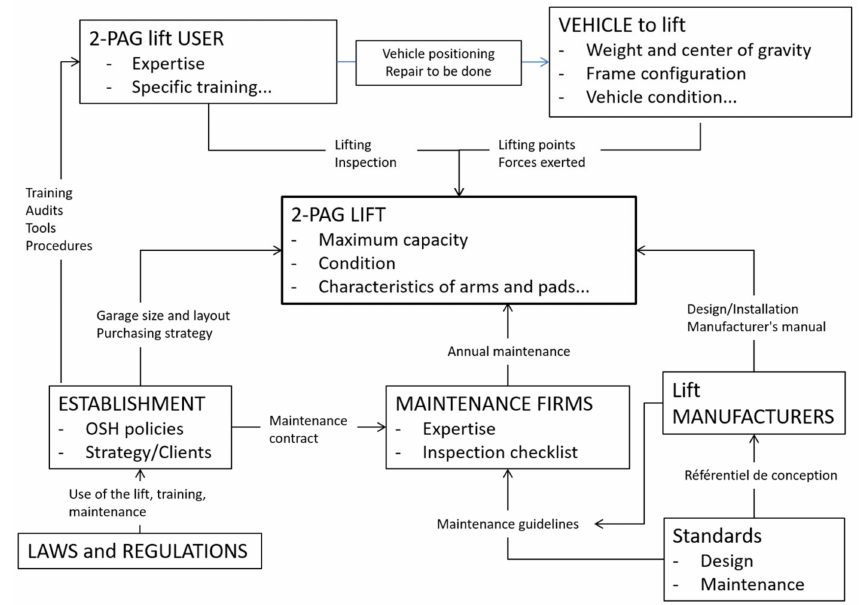
Figure 2. Context and stakeholders related to the use of 2PAG